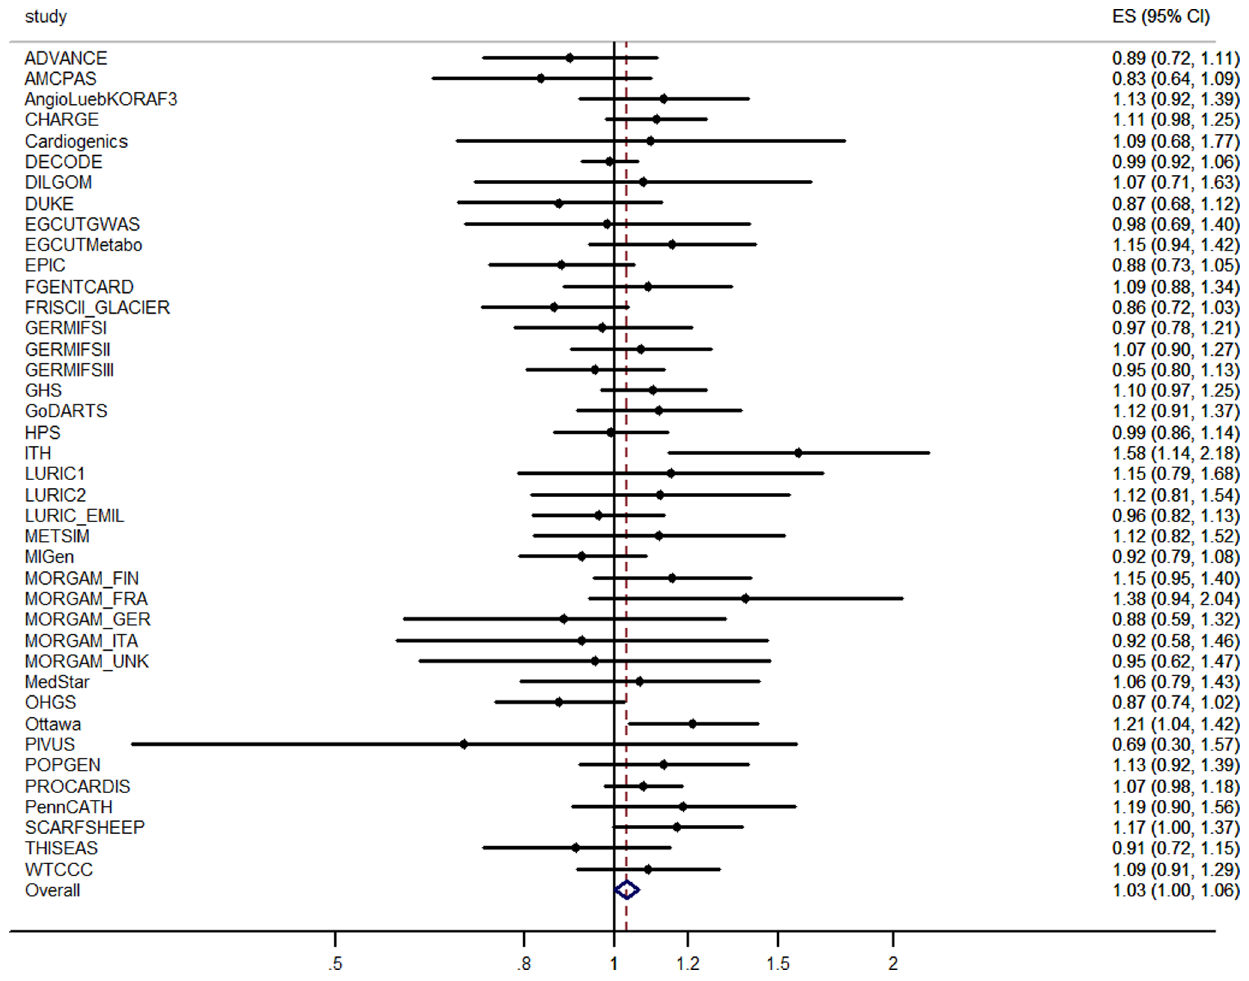
Figure 2. Forest plot for independent replication of association between rs4149313 and CAD in CARDIoGRAMplusC4D. Fixed-effect meta-analysis was applied for effect of rs4149313 on CAD in CARDIoGRAMplusC4D consortium. The diamond in the bottom represents the confidence interval of this independent replication.